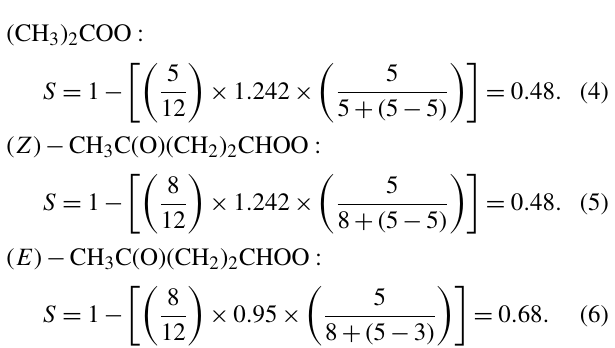
The syn - and anti -conformers of the two large CI ∗ are formed with equal yield